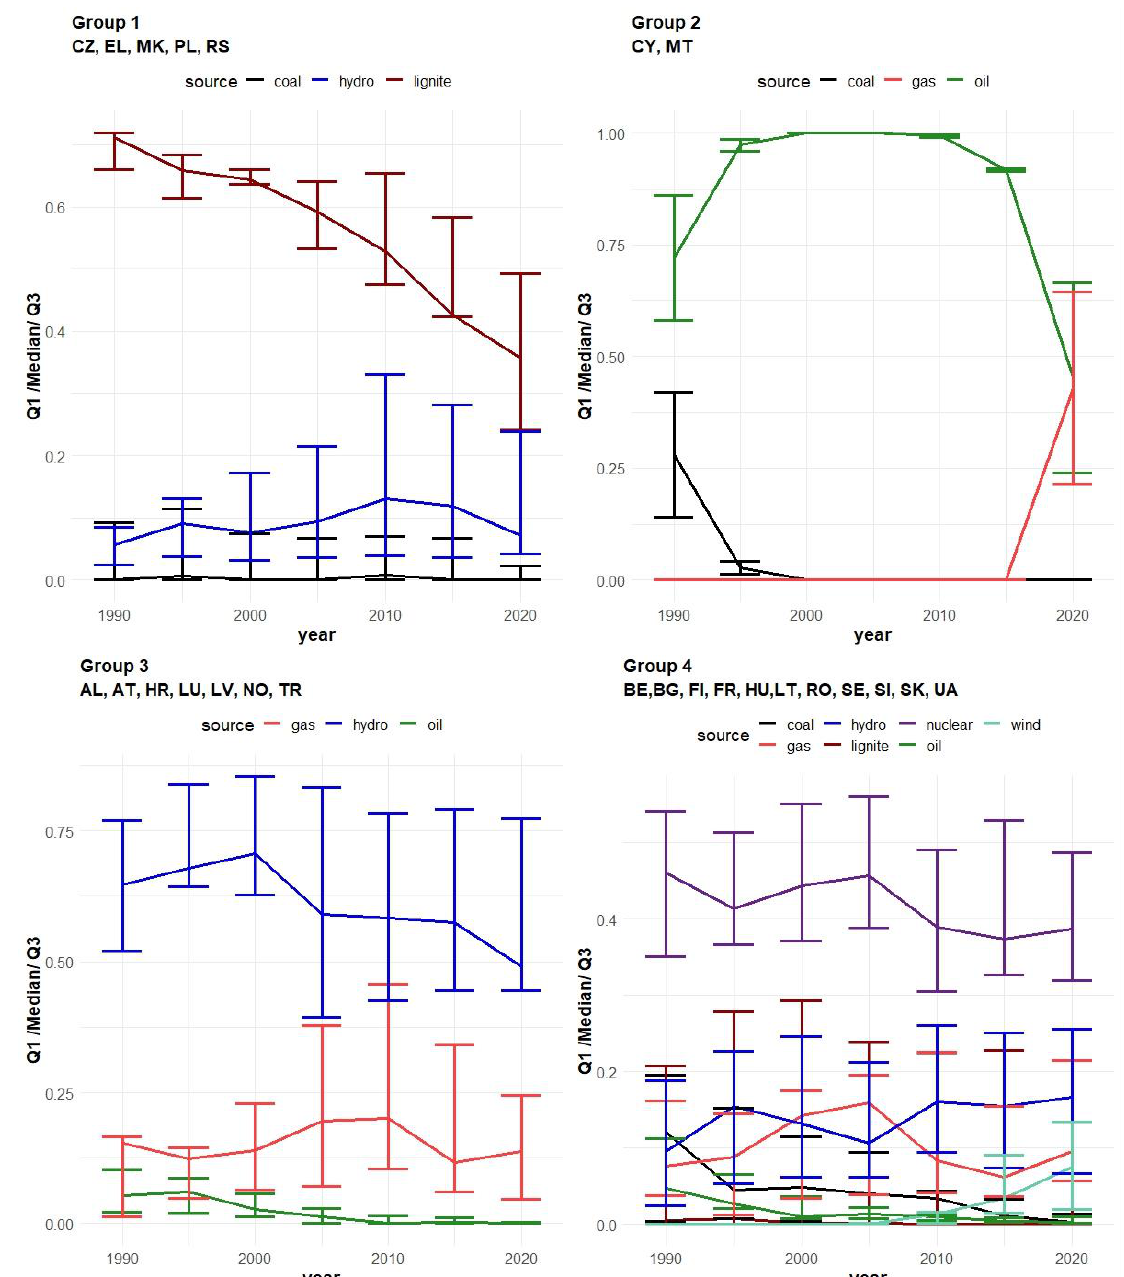
Figure 3. Changes in the structure of electricity production — clusters 1 – 4.